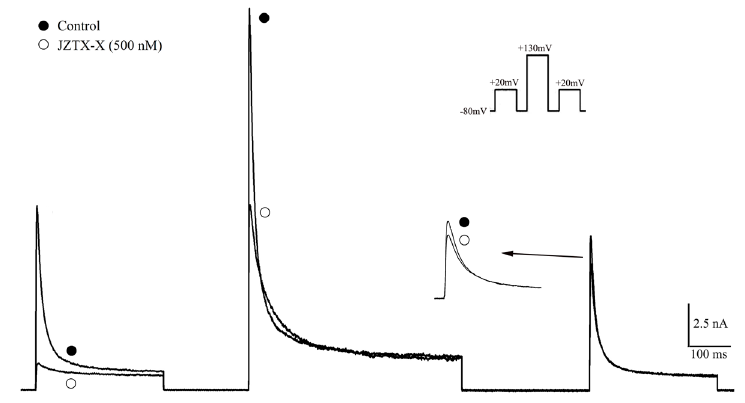
Figure 6. Potent depolarization dissociated the toxin-channel complex. The 300 ms test pulse at the voltage of +20 mV was utilized to induce the current traces. Prior to the application of test pulse, cells held at the voltage of -80 mV depolarized for 500 ms at the conditioning pulse of +130 mV and the holding potential of 50 ms (see inset). Following 500 nM JZTX-X perfusion, the test pulse-elicited current amplitude was nearly identical to the control after the 500 ms conditioning pulse.